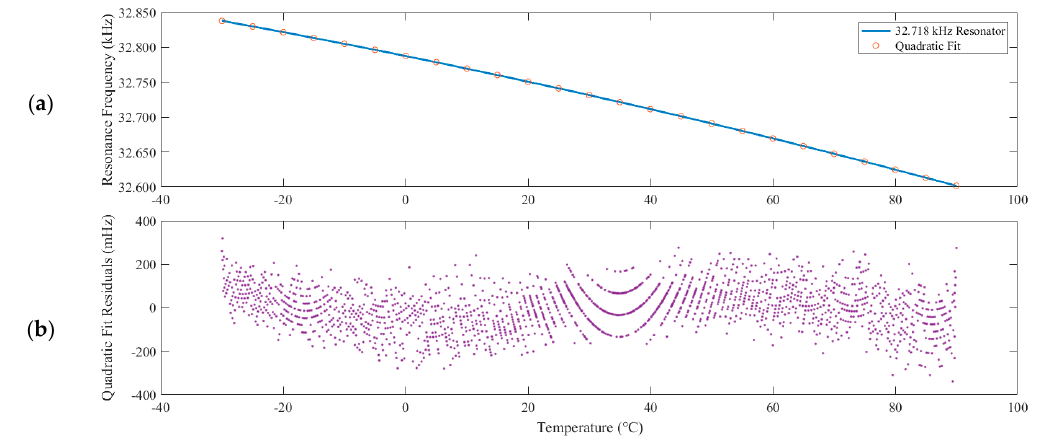
Figure 4. ( a ) Characterization of the resonance frequency of the sensor element as function of the temperature with a quadratic fit ( b ) Residuals of the fitted curve in